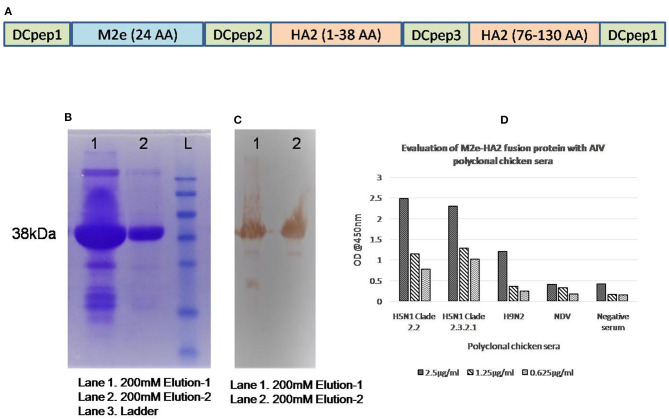
Gene construction and expression of M2e–HA2 recombinant protein in Escherichia coli Rosetta Blue (DE3)pLysS. Sodium dodecyl sulfate-polyacrylamide gel electrophoresis (SDS-PAGE) and Western blot analysis and evaluation of recombinant M2e–HA2 protein by indirect ELISA with positive control sera. (A) Synthetic gene constructs coding for M2e (2–24 AA) and HA2 conserved regions (N-terminal 1–38 AA and Long α-helix 76–130 AA) with chicken dendritic cell binding peptides were designed by placing glycine linkers (GGG) in between them. (B) SDS-PAGE analysis of recombinant M2e–HA2 protein by Coomassie blue stain and (C) Western blot analysis of recombinant M2e–HA2 protein (38 kDa) showed high reactivity with polyclonal avian influenza virus (AIV) serum. (D) Indirect ELISA with recombinant M2e–HA2 fusion protein showed high reactivity with different clades (2.2 and 2.3.2.1) of H5N1 AIV, H9N2 AIV but failed to react with NDV and control chicken serum.